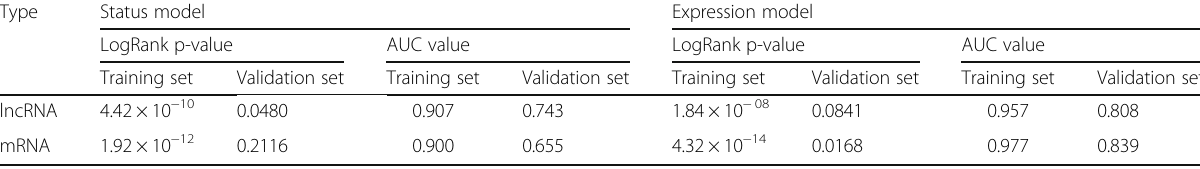
Table 2 Predictive performances of four prognosis prediction models based on expression levels or status of lncRNAs or mRNAs